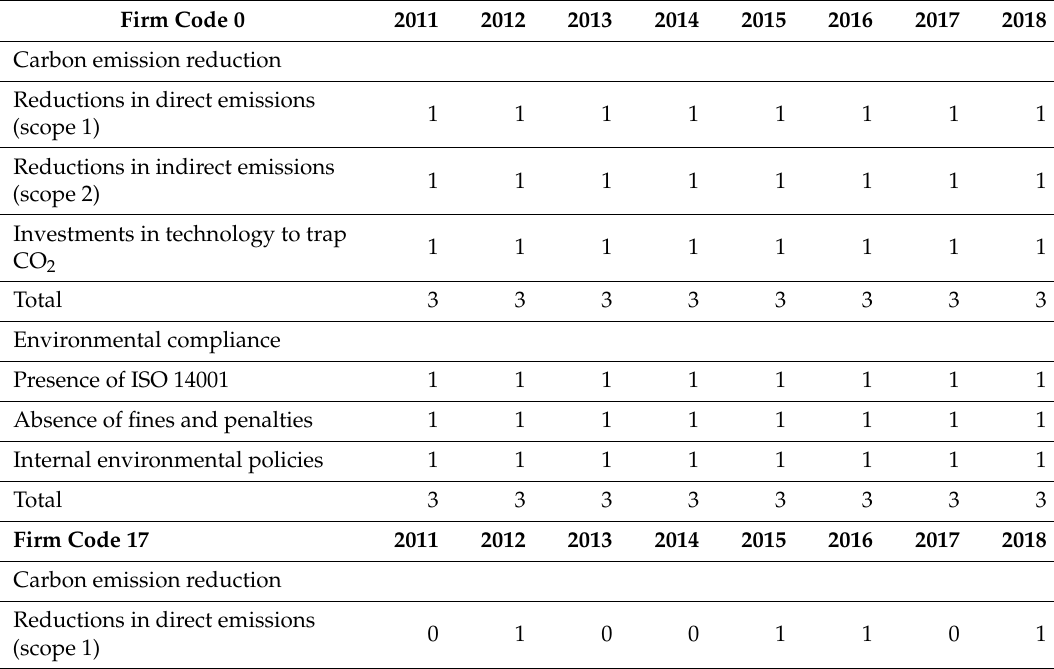
Table 2. Content Analysis